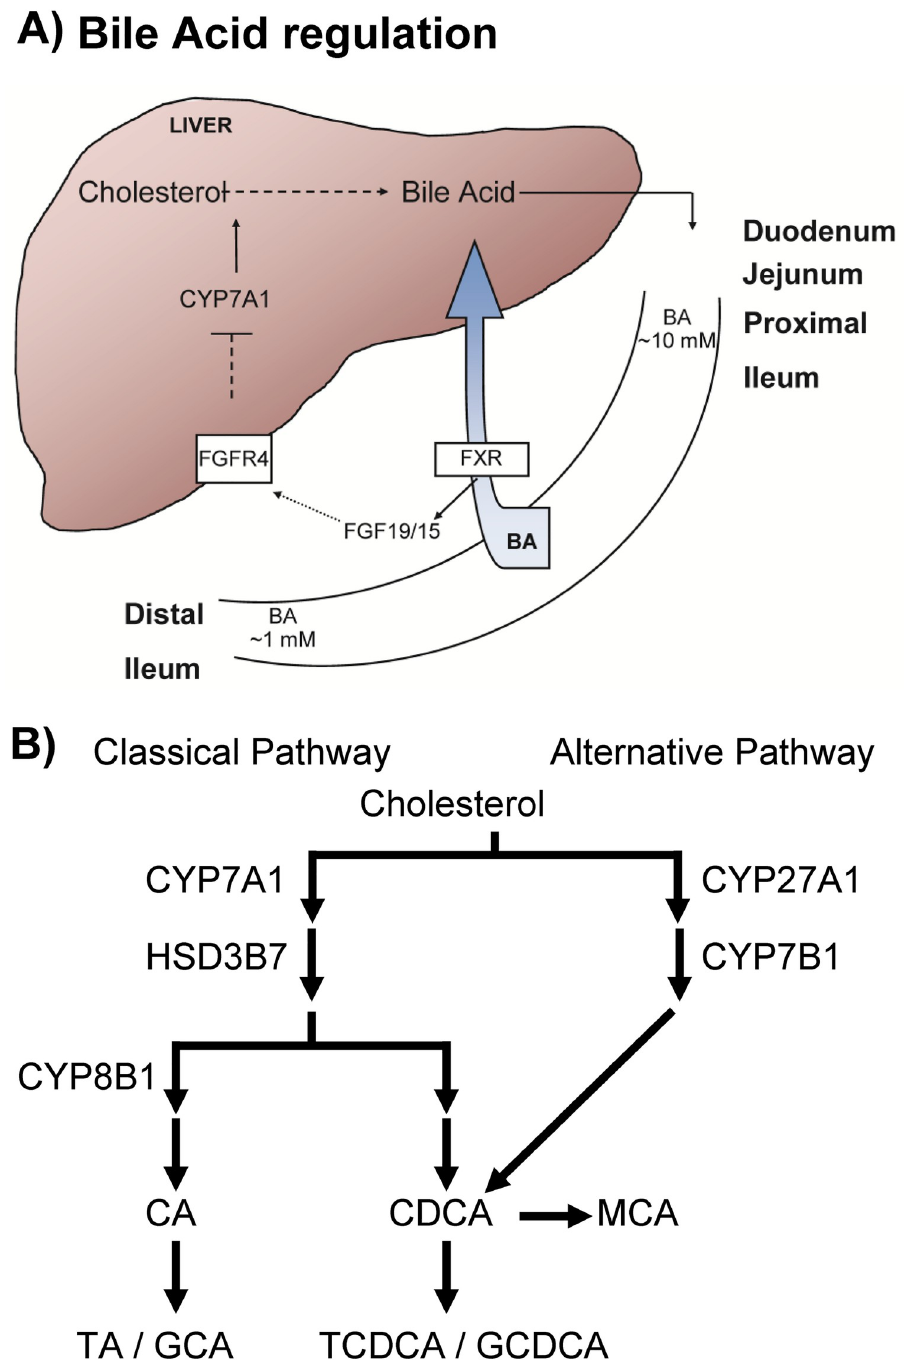
Fig 1. Bile acid regulation. A ) Bile acids are synthesized in the liver and secreted into the GI at a concentration of nearly 10 mM. During GI transit, approximately 90% is actively reabsorbed and recycled into the liver to be used in new rounds of digestion. During this recycling, bile acids signal through FXR, FGF19/15 and FGFR4 to regulate the rate limiting step of bile acid synthesis, CYP7A1. B ) Bile acids are synthesized in two pathways. In the alternative pathway, only CDCA (chenodeoxycholate) derivatives (in humans) and CDCA / MCA (muricholate) derivatives (in mice) are made. In the classical pathway, both CDCA and CA (cholate) derivatives are formed. CA synthesis is dependent on CYP8B1 and the absence of CYP8B1 leads to only CDCA (and MCA) formation.